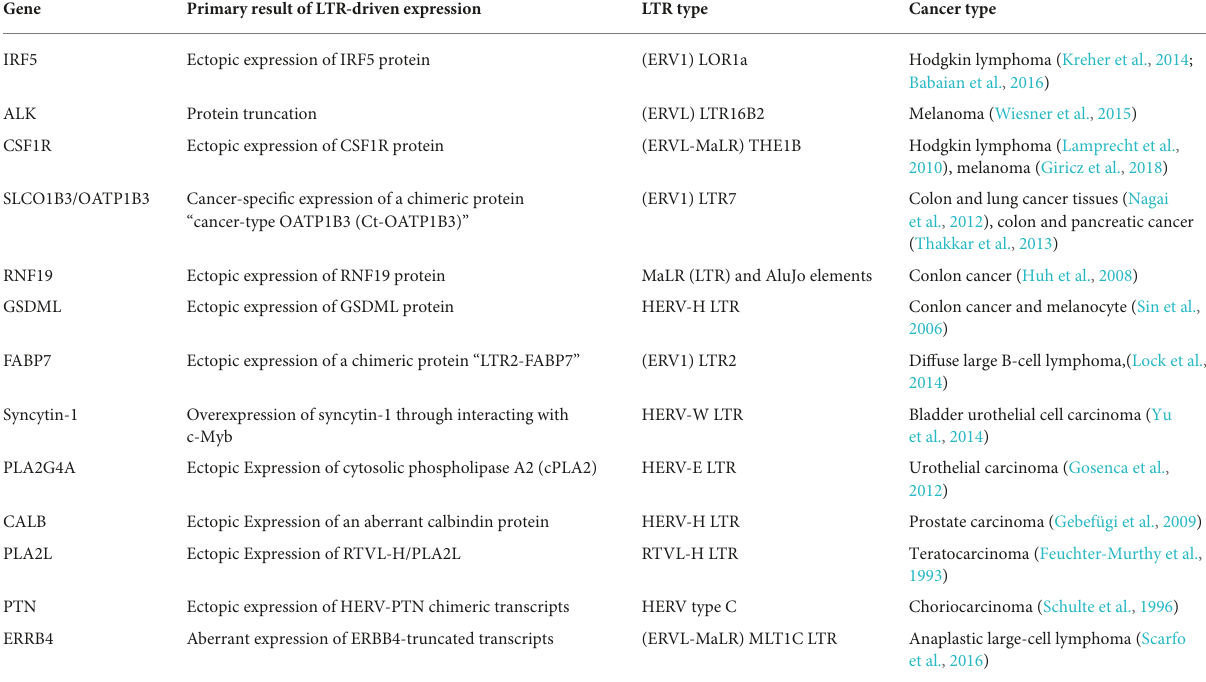
TABLE 2 Onco-exaptation of LTR-derived oncogenes expression in